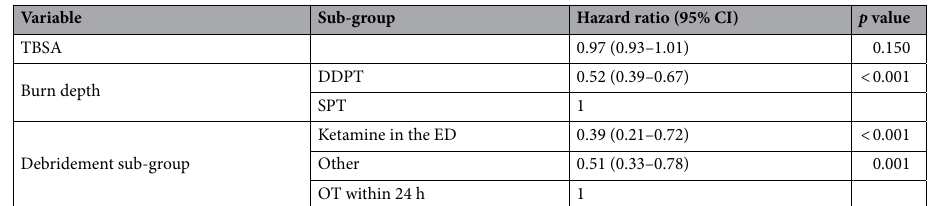
Table 2. Time to re-epithelialisation Cox regression (hazard ratios) n = 233. NB: All grafted patients N = 59, were excluded from this analysis. DDPT deep dermal partial thickness, SPT superficial partial thickness,